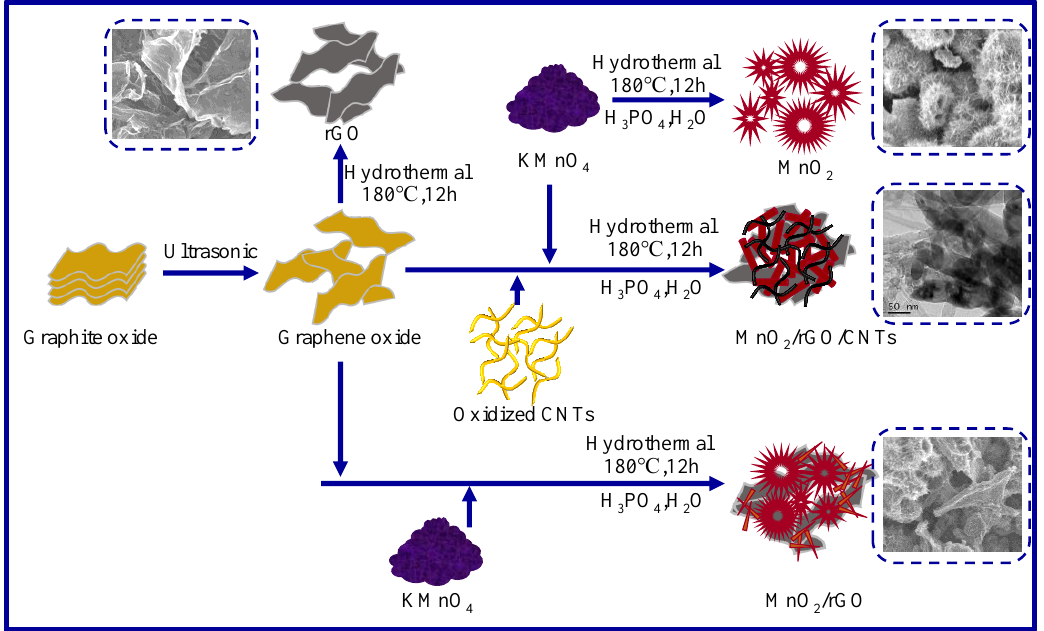
Figure 1. The schematic synthesis processes of MnO 2 , MnO 2 /rGO, and MnO 2 /rGO/CNTs. rGO: reduced graphene oxide; CNTs: carbon nanotubes.